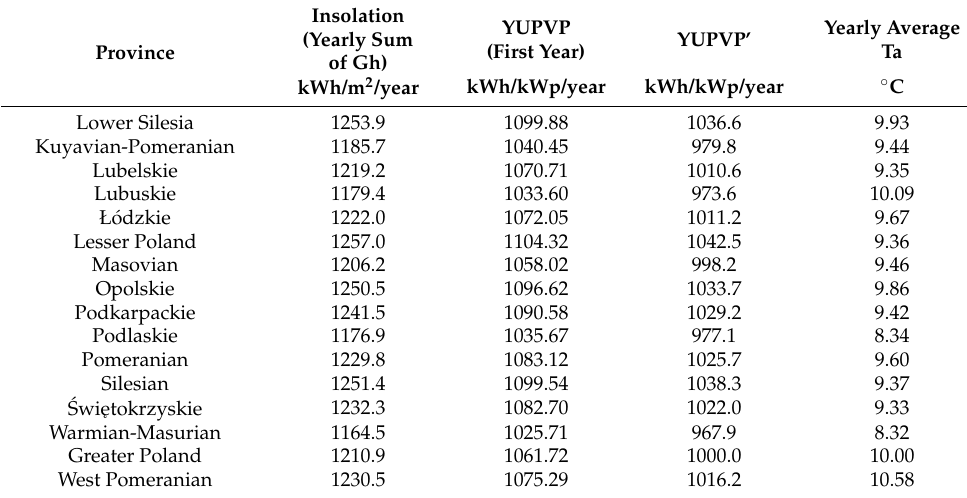
Table 1. Insolation, yearly electricity productivity, and yearly average temperature outside per province. Authors’ study based on